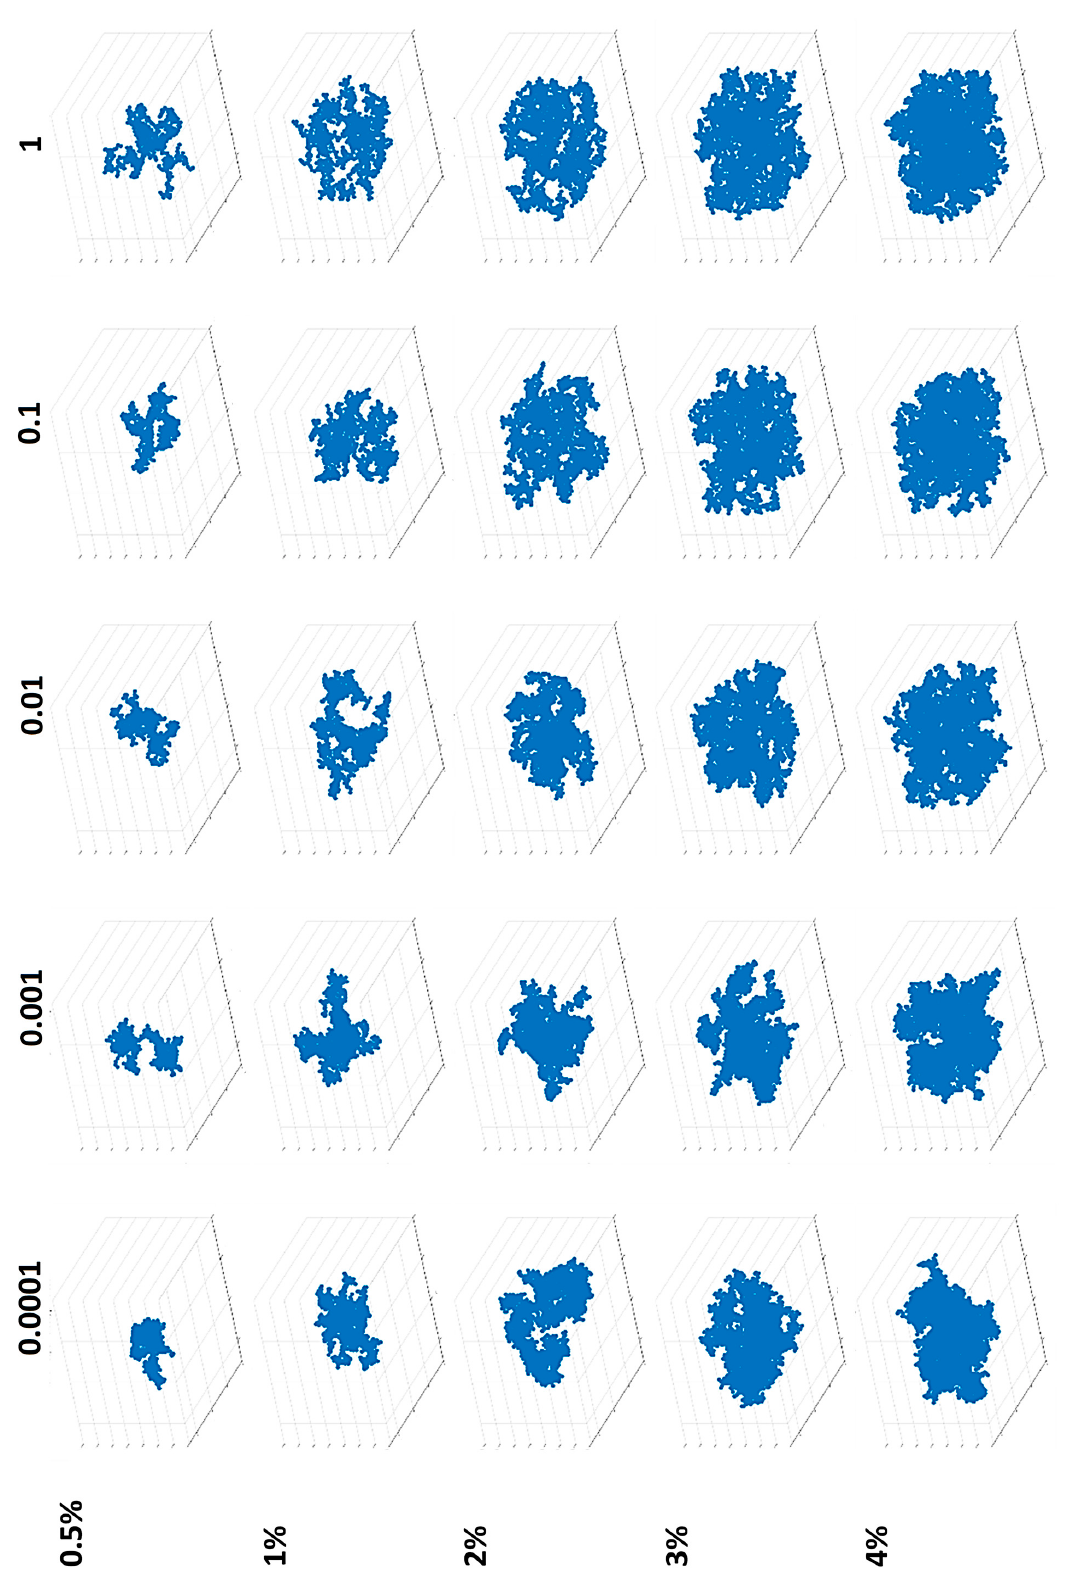
Figure A1. The numerically obtained structures for various secondary particle concentration (hori- zontal axis) and probability of an effective collision (vertical axis)—all 25